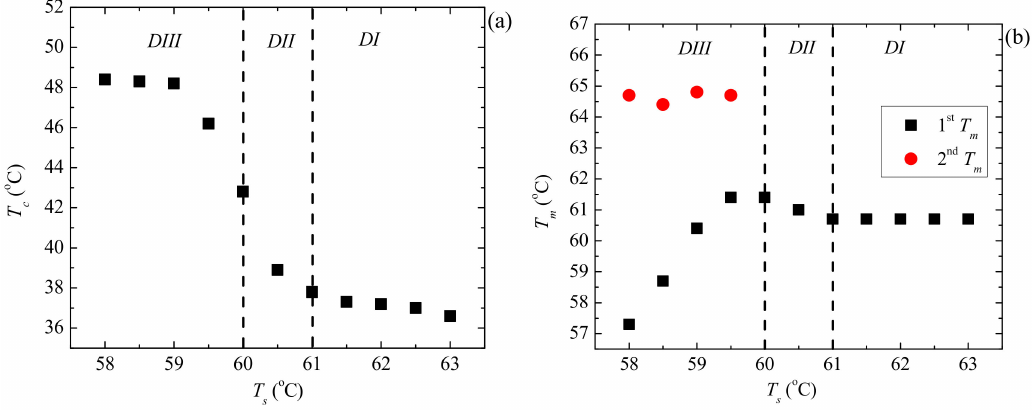
Figure 15. Dependence of ( a ) crystallization and ( b ) melting peak temperatures of neat PCL on T s